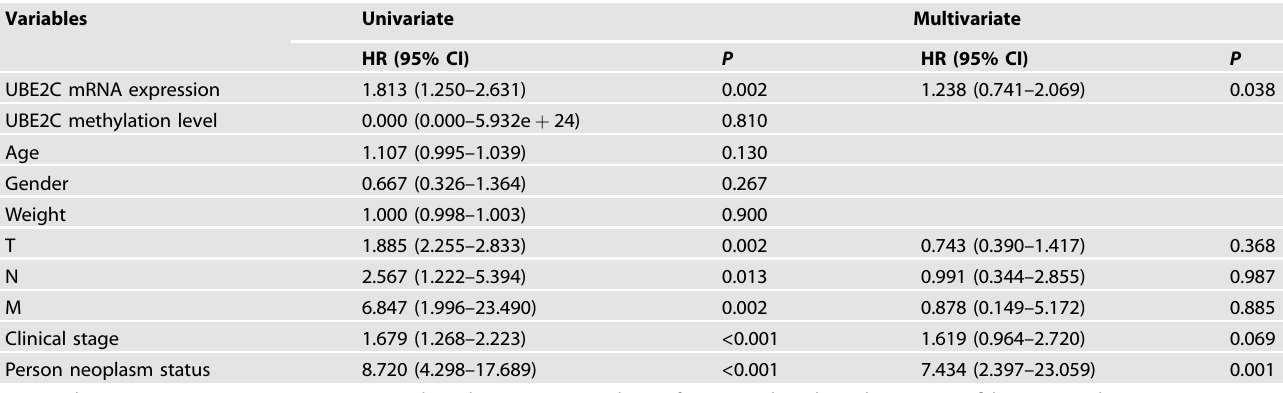
Fig. 1 The in fl uence of UBE2C expression on the prognosis of patients. A Prognostic impact on DFS of THCA patients. B ROC curve for assessing diagnostic value of UBE2C in THCA. C Prognostic impact on OS of THCA patients. D Prognostic impact of UBE2C among 33 human cancer types. UBE2C ubiquitin-conjugating enzyme E2 C, THCA thyroid carcinoma, DFS disease-free survival, OS overall survival, ROC receiver operating Table 2. Cox regression analysis in terms of DFS in THCA.